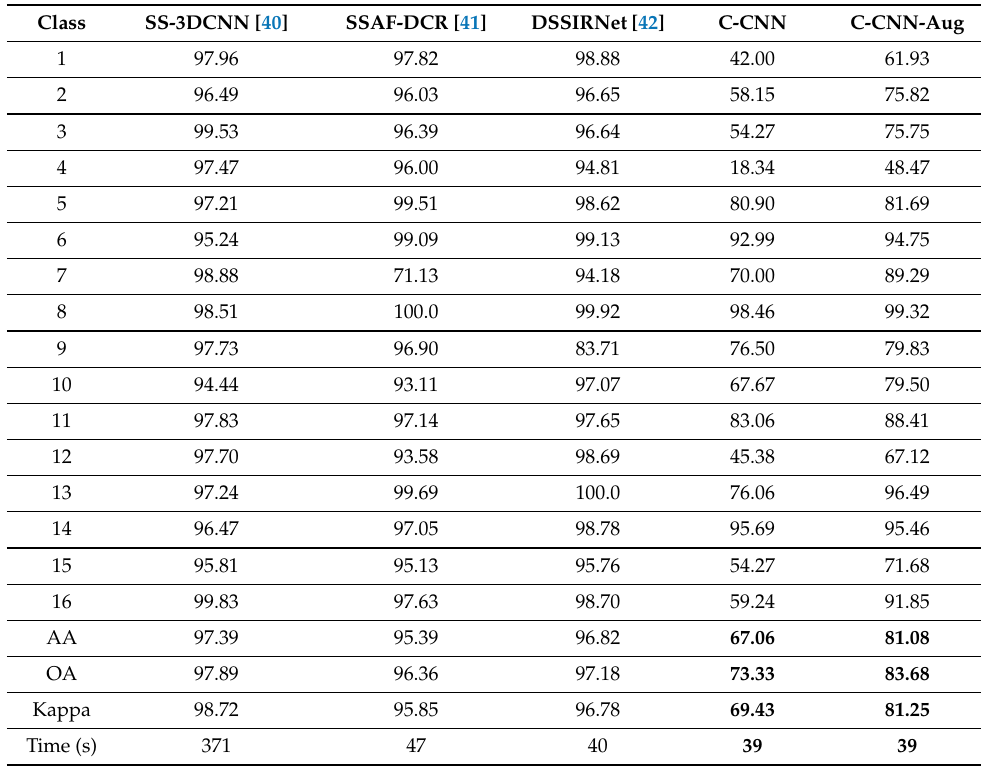
Table 4. The accuracy comparison of Indian Pines classification.